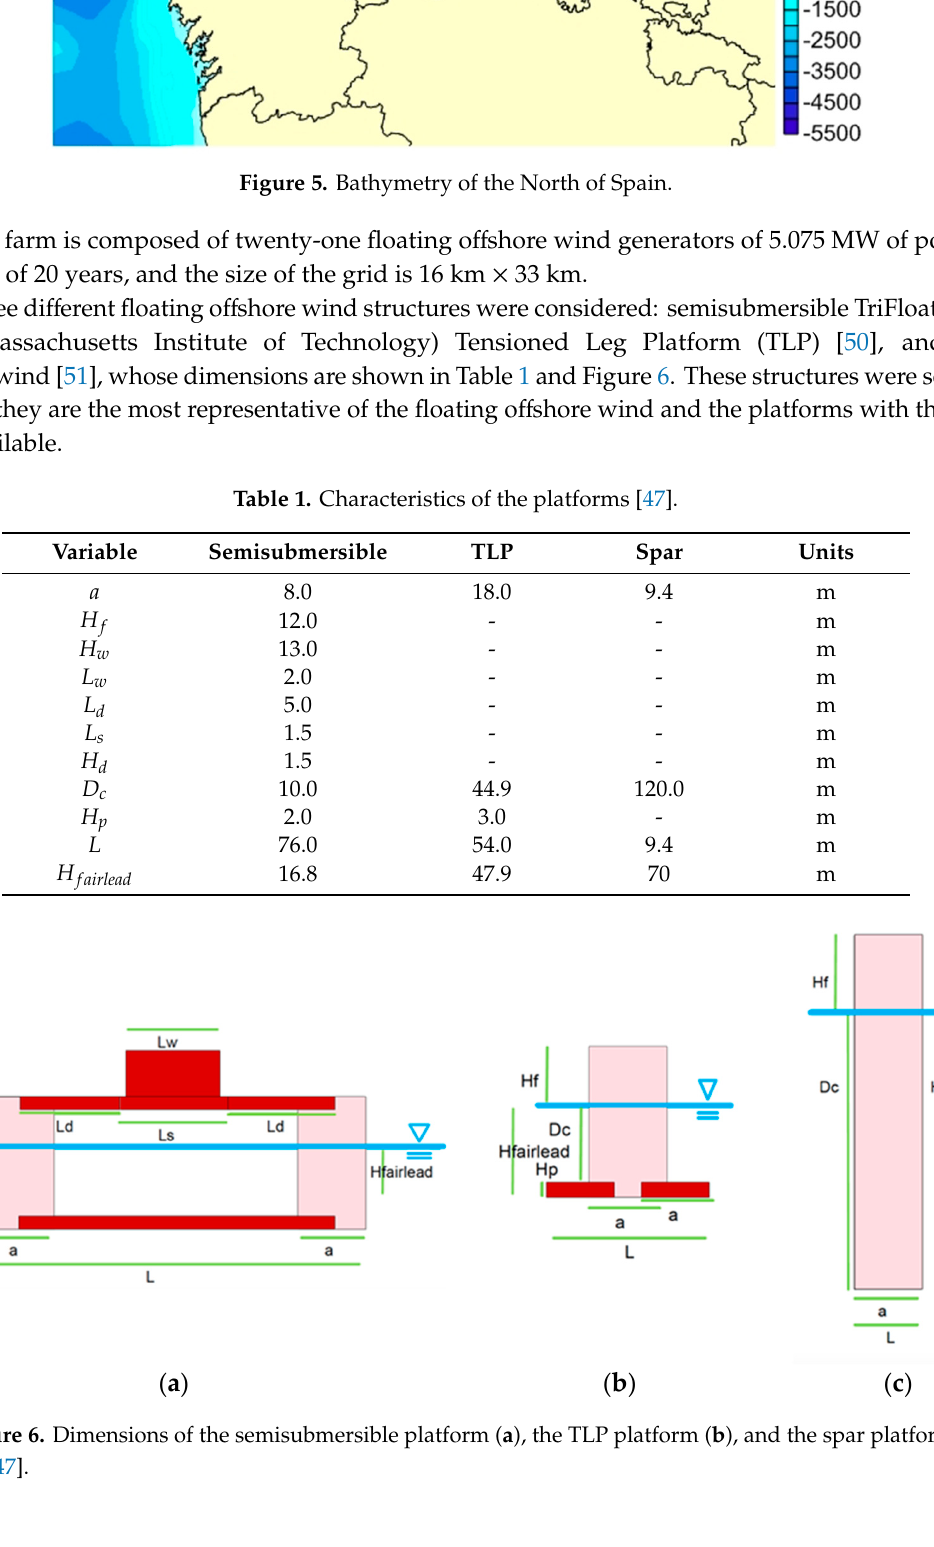
Figure 4. Scale of the offshore wind parameter for the North of Spain.